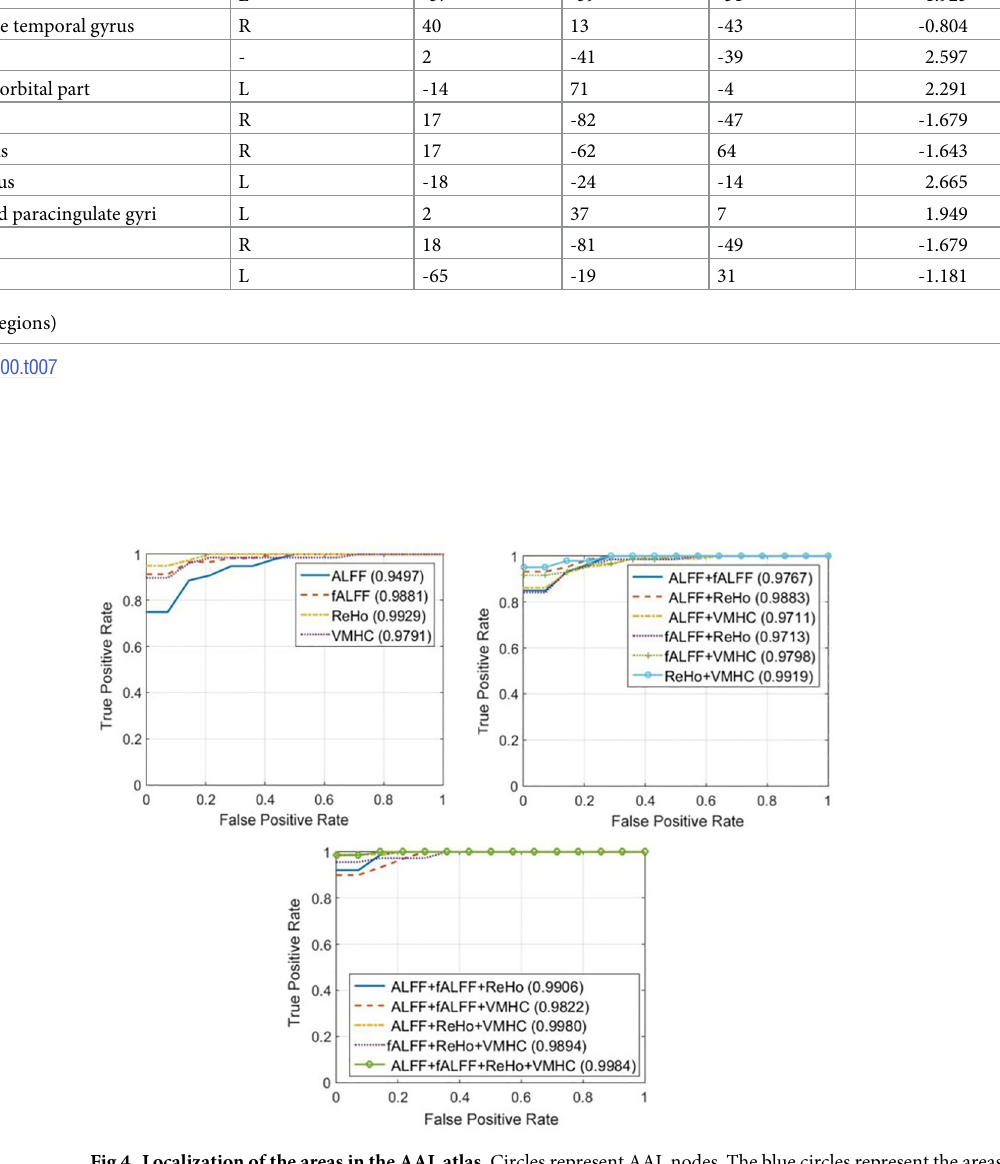
Fig 4. Localization of the areas in the AAL atlas. Circles represent AAL nodes. The blue circles represent the areas with higher discriminability between healthy and schizophrenia groups and the green circles represent unaffected